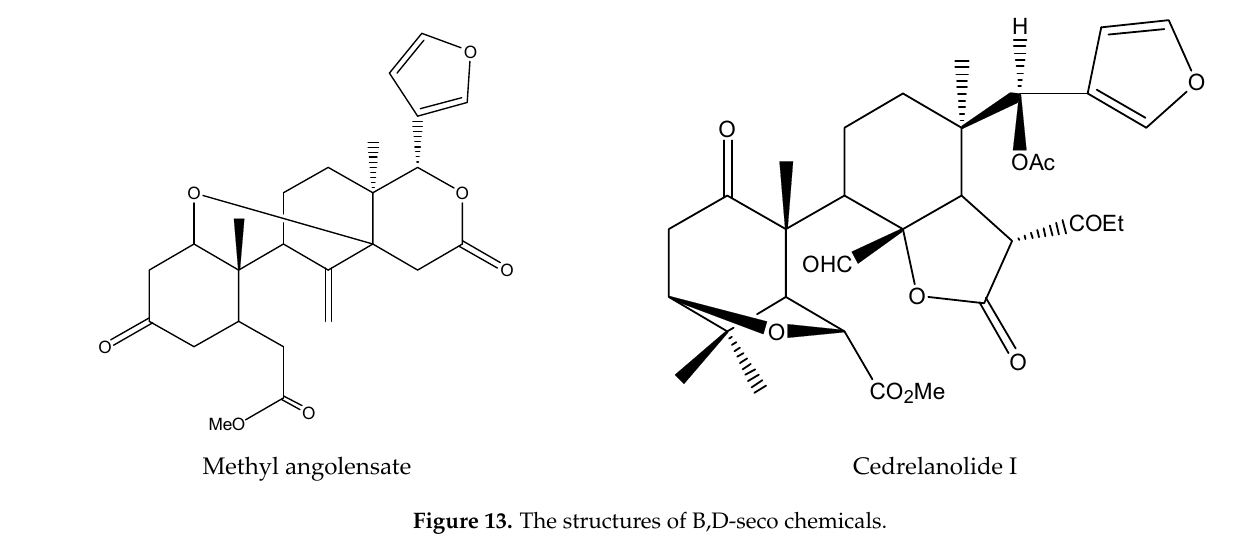
Figure 13. The structures of B,D-seco chemicals.